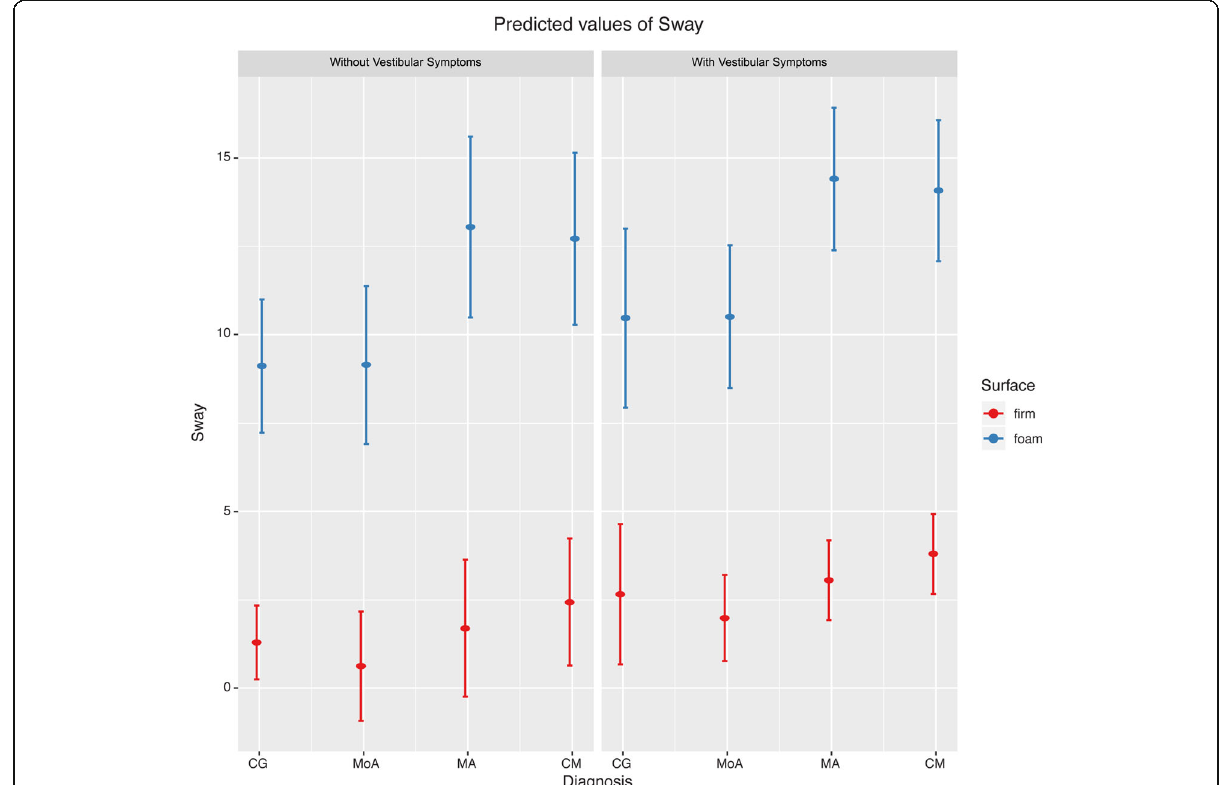
Fig. 1 Predicted sway based on the model with and without vestibular symptoms. Left: vestibular symptoms absent; Right: vestibular symptoms